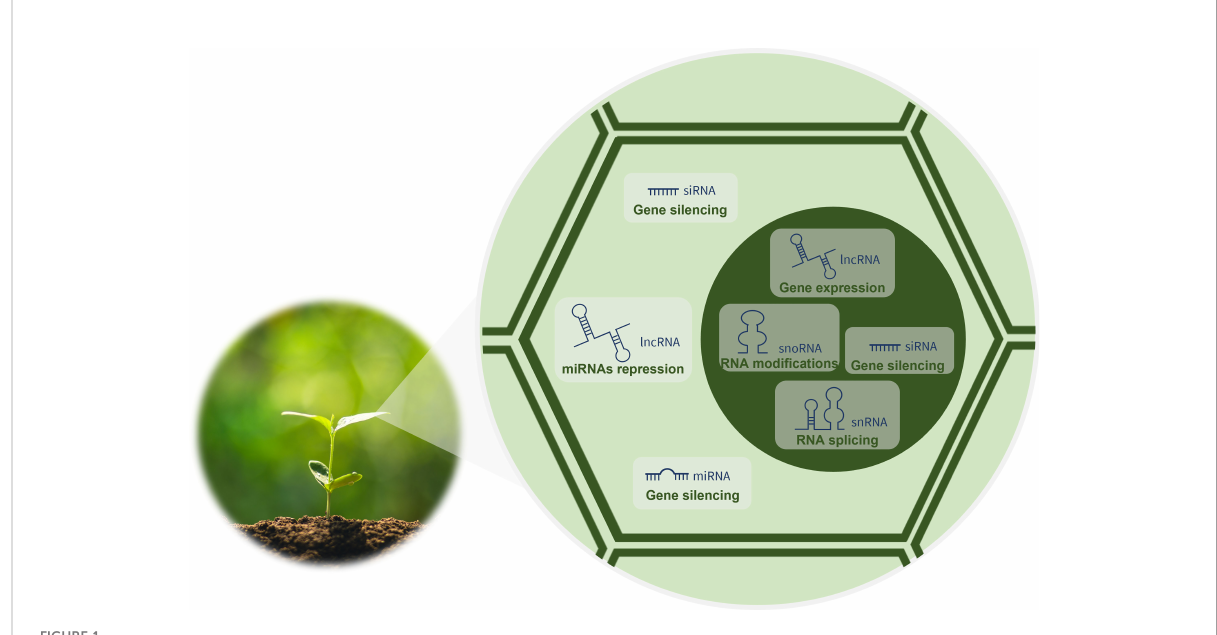
FIGURE 1 Functions of regulatory ncRNAs in plant